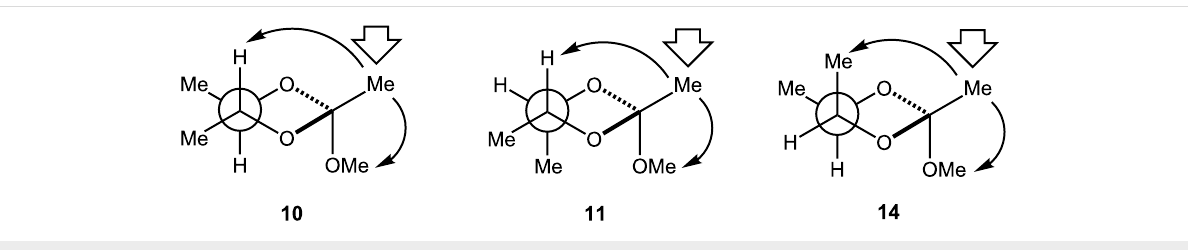
Figure 3: The assignment of 10 – 11 and 14 via nOe [viewed C(4) → C(5)].